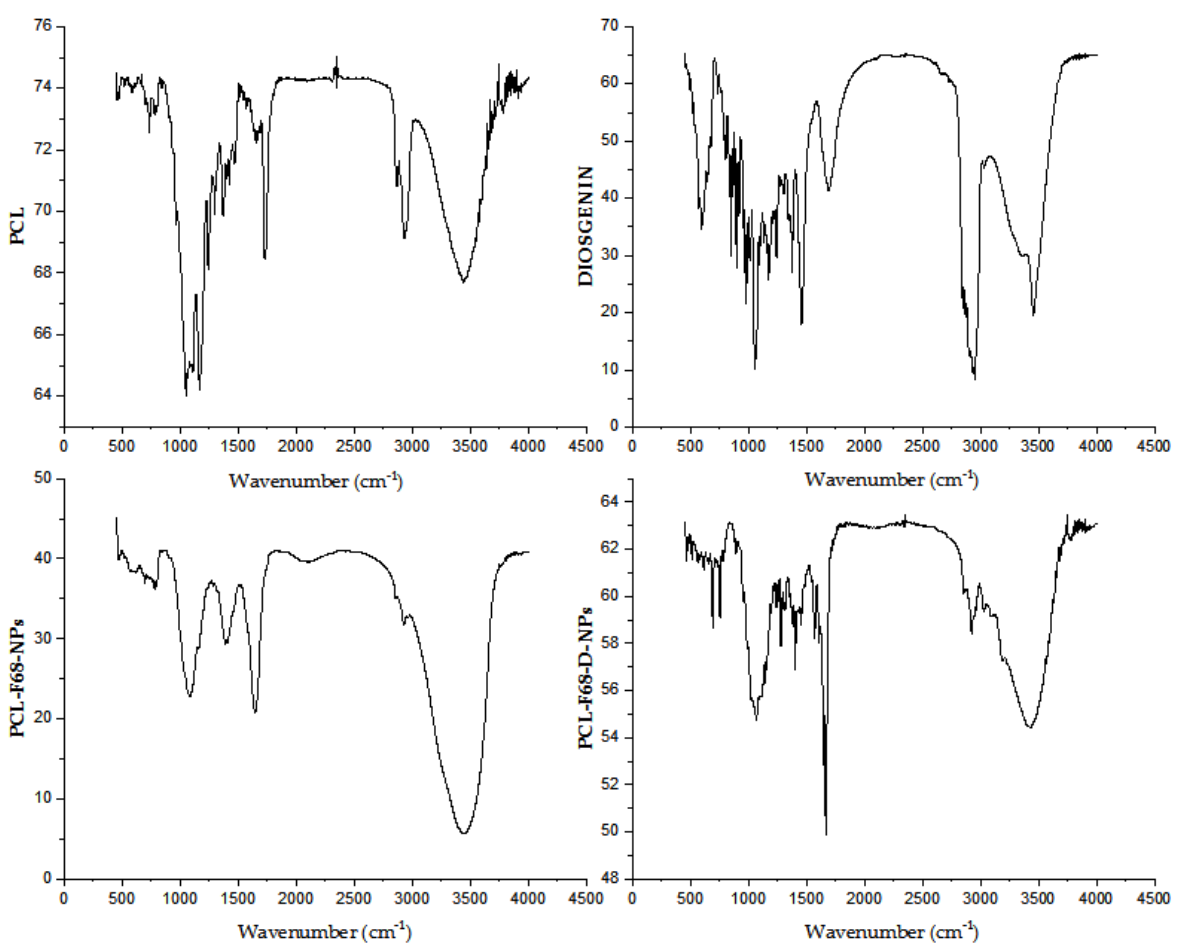
Figure 1. Fourier-transform infrared (FTIR) spectra of polycaprolactone (PCL), Diosgenin, blank nanoparticles (PCL-F68- NPs), and Diosgenin-loaded nanoparticles (PCL-F68-D-NPs).